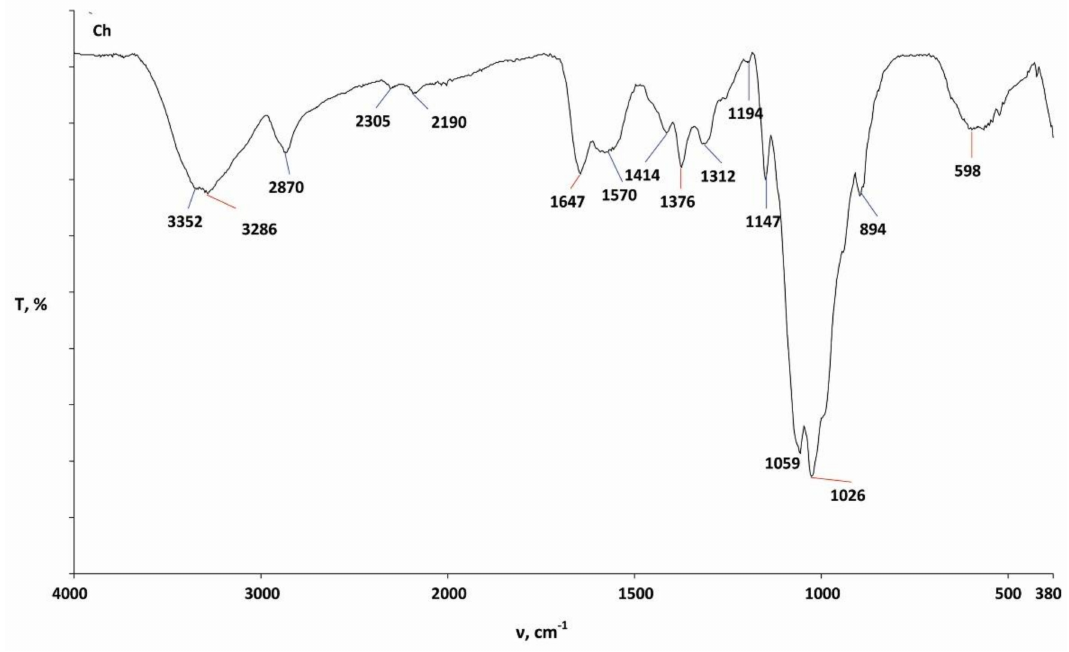
Figure 5. Fourier Transform Infrared Spectroscopy (FTIR) spectrum of chitosan